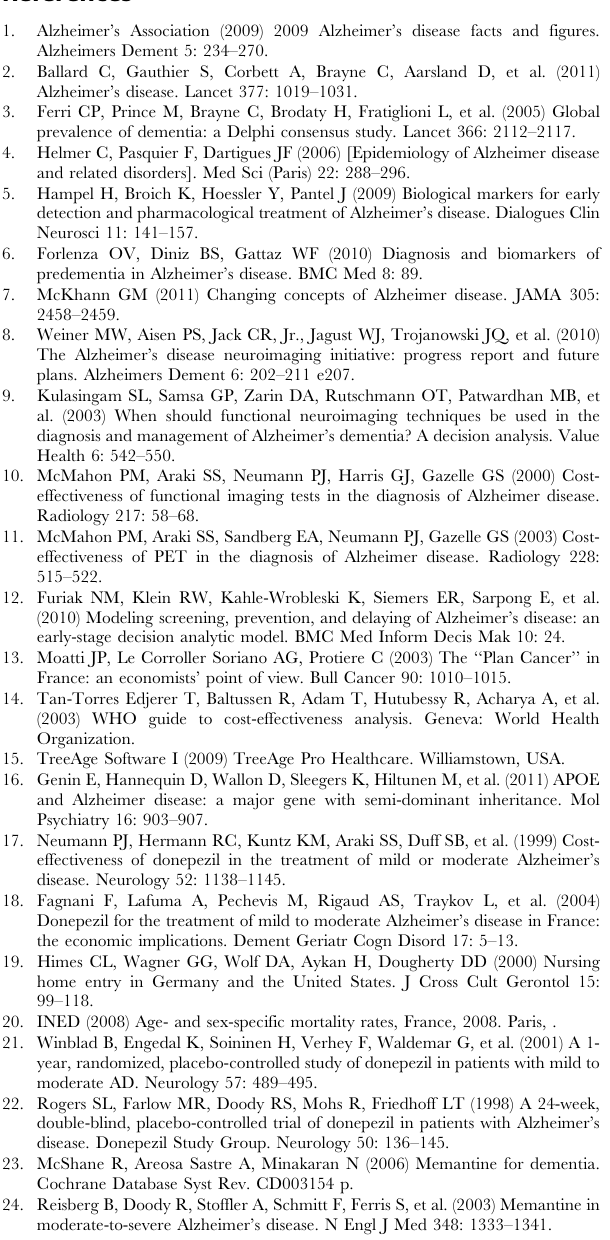
Table S1 Model parameters: base-case values and ranges investigated in the sensitivity analyses. Table S2 Univariate sensitivity analysis: incremental cost-effectiveness ratio (ICER) of the MRI + CLP strategy,